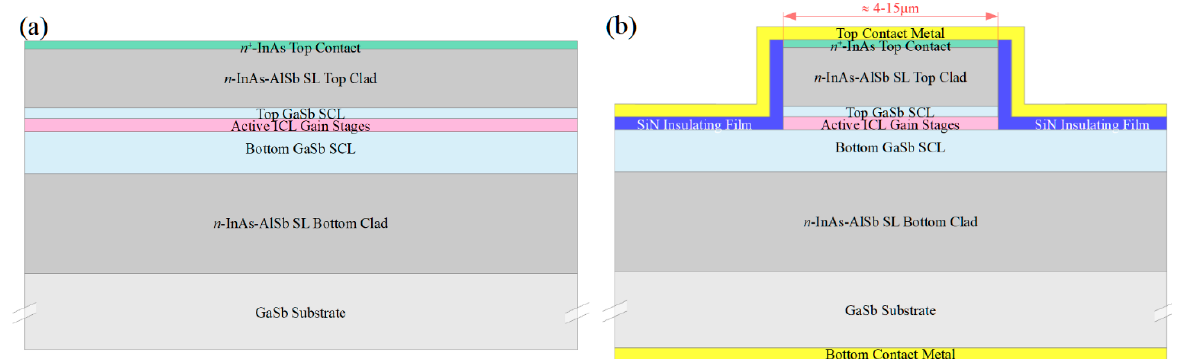
Figure 1. ( a ) Schematic layering of an interband cascade laser (ICL) grown on GaSb. The primary regions are the active gain stages, top and bottom high-index/low-loss n − -GaSb separate confinement layers, top and bottom InAs-AlSb superlattice optical cladding layers, and an n + -InAs top contacting layer. ( b ) Schematic cross-section of an ICL narrow ridge waveguide formed by etching through the active stages of the wafer material illustrated in Figure 1a. The same ridge structure may provide gain when forward biased, or function as a detector under zero or reverse bias. Typical layer thicknesses are 2–4 µ m for the bottom cladding layer, 500–900 nm for the bottom SCLs, 200–400 nm for 5–10 active gain stages, 100–300 nm for the top separate confinement layer (SCL), 1.2–2 µ m for the top cladding layer, and 20 nm for the top contact layer.